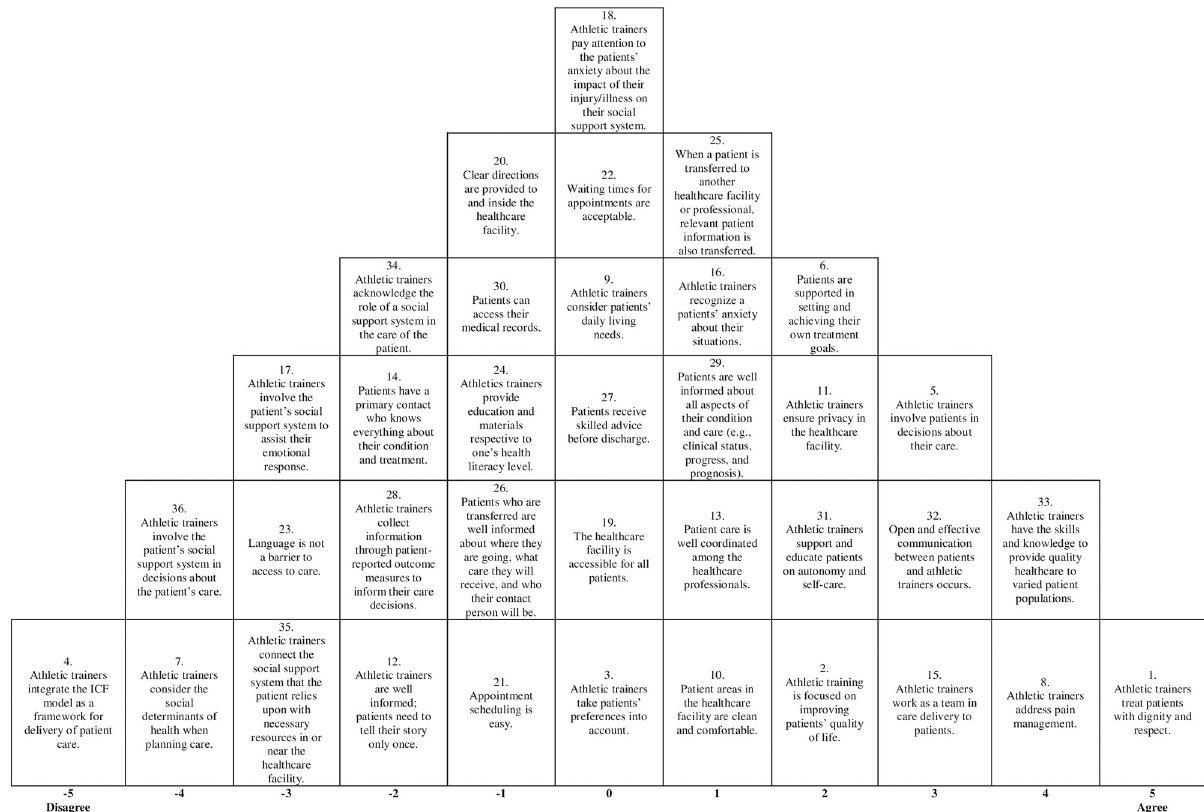
Fig 1. Composite Q-sort 1. The sort further describes the importance of the 36 PCC statements for viewpoint